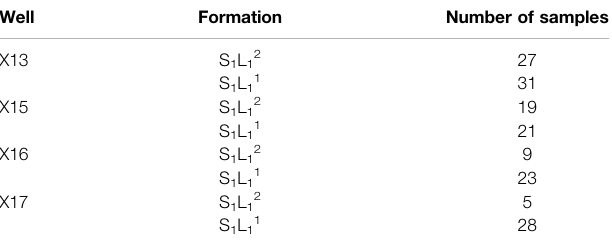
TABLE 2 | The samples of fi eld desorption experiments in the Changning area.